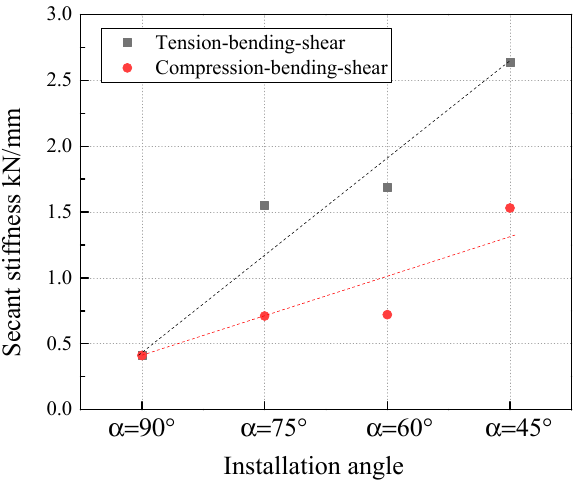
Figure 11. Comparison of stiffness.